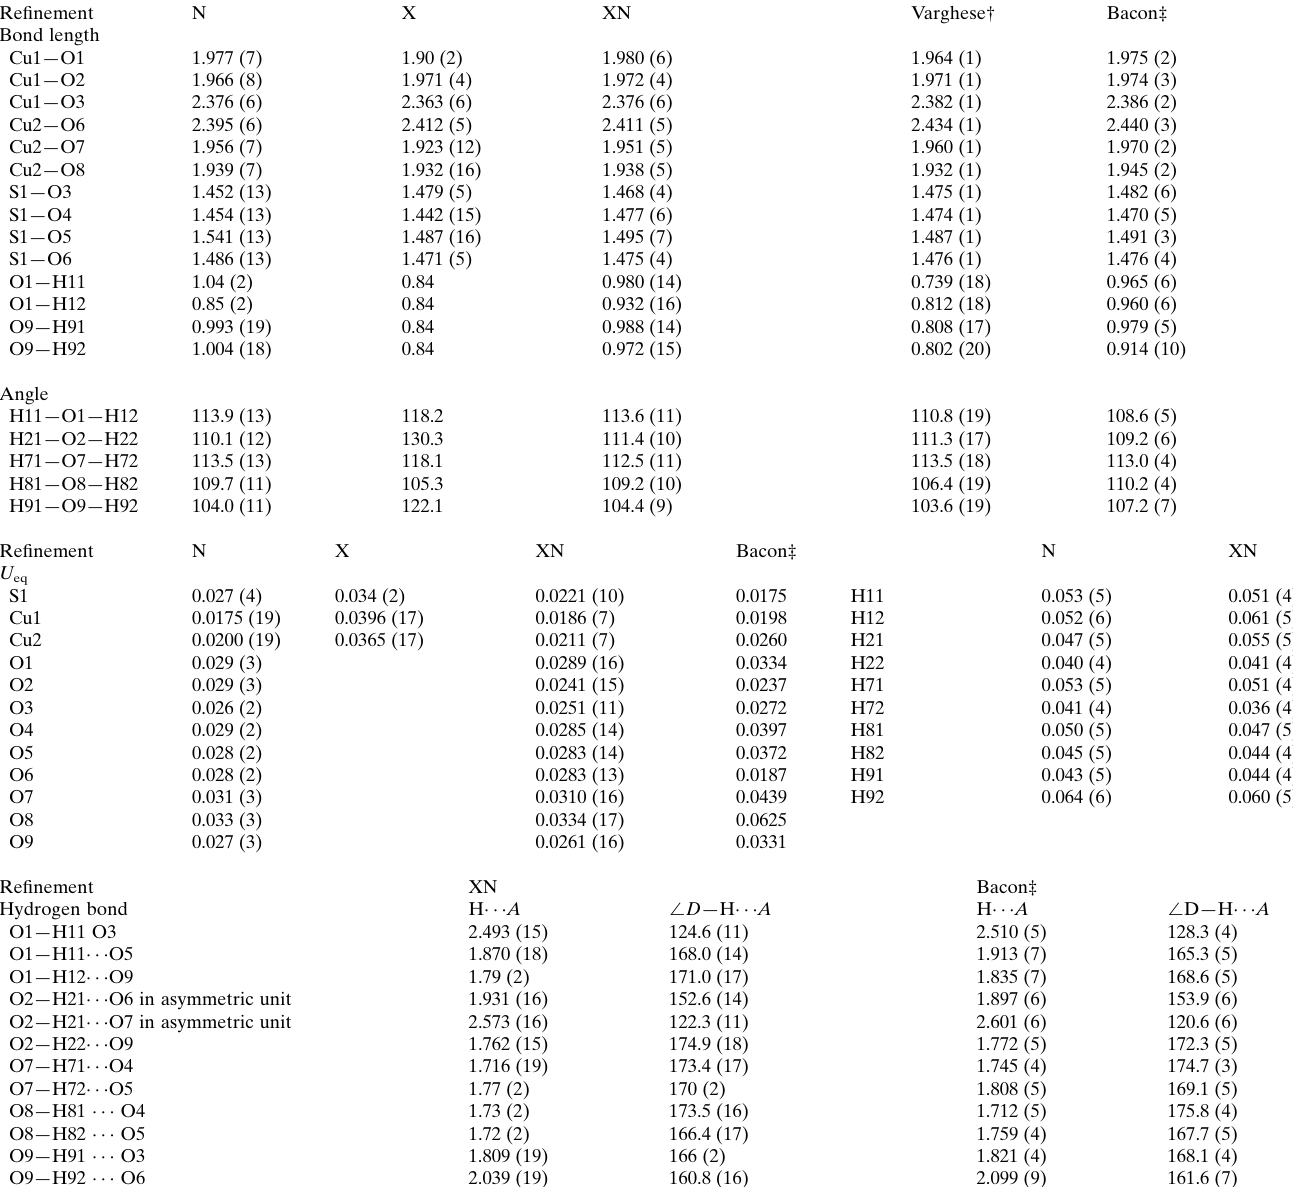
Table 3 Comparison of selected bond distances (A˚ ), angles ( (cid:6) ) and U eq (A˚ 2 ) of copper sulfate pentahydrate at 0.71 GPa, obtained by neutron (N), X-ray (X) and joint (XN) refinements, with selected corresponding values at ambient conditions from the